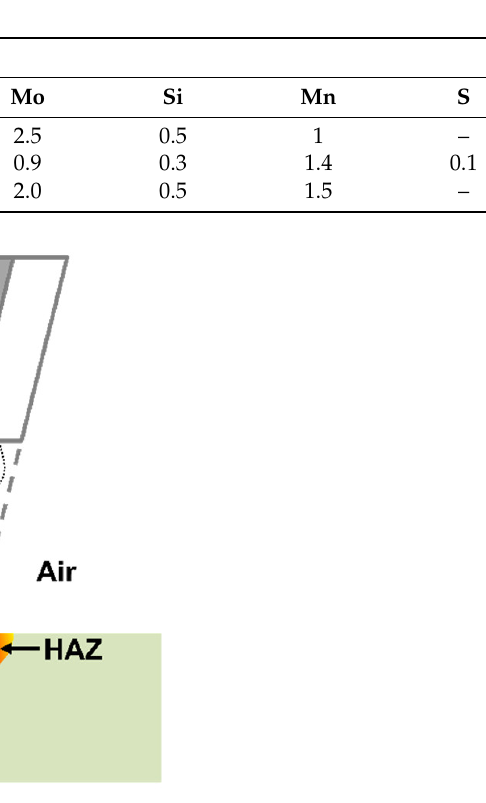
Figure 6. Schematic representation of the coaxial nozzle system with laser and powder flow being surrounded by Ar shielding gas. Portions of the printed clads that are left behind by the moving nozzle during manufacturing and the vicinity of the clads (for instance the HAZ region) are exposed to ambient air while still at elevated temperatures.